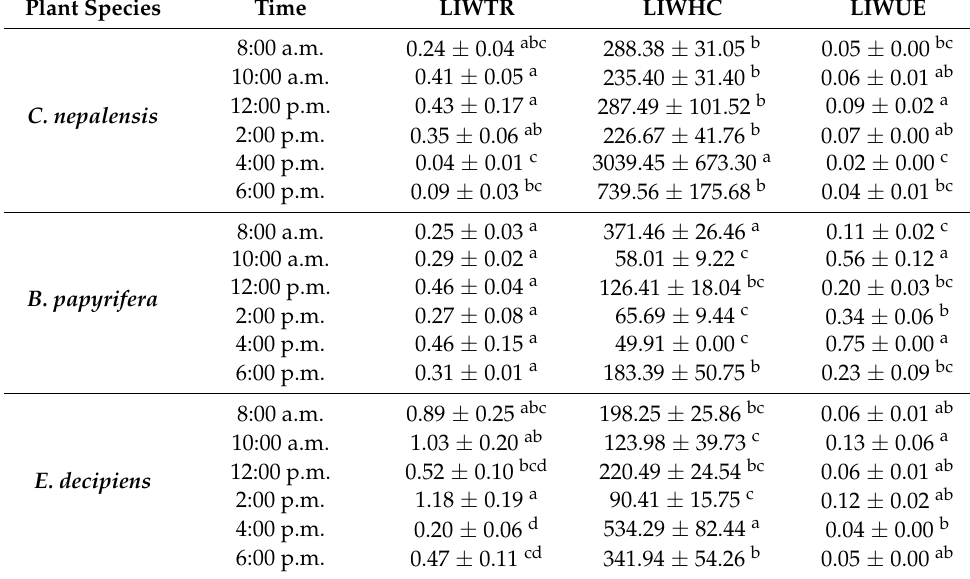
Table 2. Leaf intracellular water transport rate (LIWTR, ΜΩ∙ N − 1 ), leaf intracellular water ‐ holding capacity (LIWHC), and leaf intracellular water ‐ use efficiency (LIWUE) of C. nepalensis, B. papyrifera , and E. decipiens . Data are shown as the means ± SE ( n = 5). Different lowercase letters in the same column indicate significant differences between different timepoints.